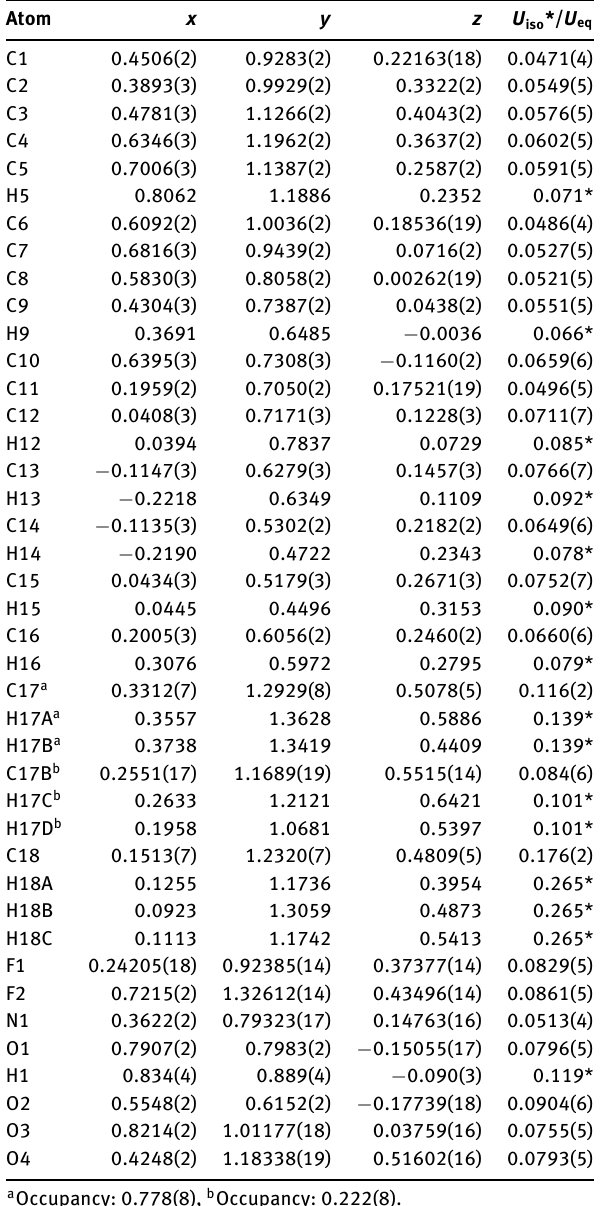
Table 2: Fractional atomic coordinates and isotropic or equivalent isotropic displacement parameters (Å 2